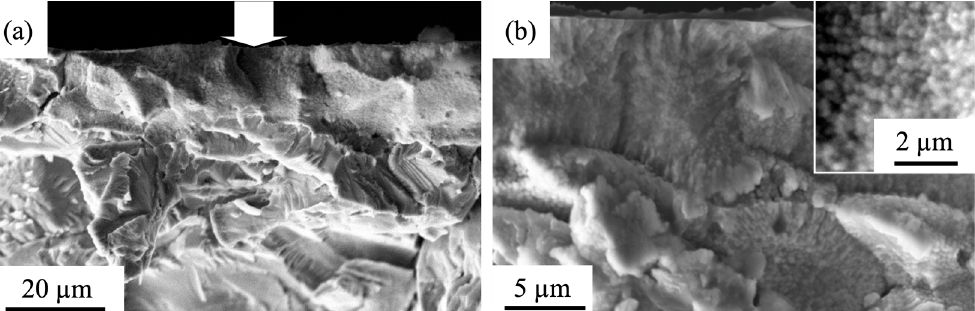
Figure 7. SEM images of a surface fracture of HEA irradiated by HCPEB (20 J/cm 2 , 50 µs, 3 pulses, 0.3 s –1 ). ( a ) Magnification × 2500. ( b ) Magnification × 10000. The arrow ( а ) indicates the irradiated surface.